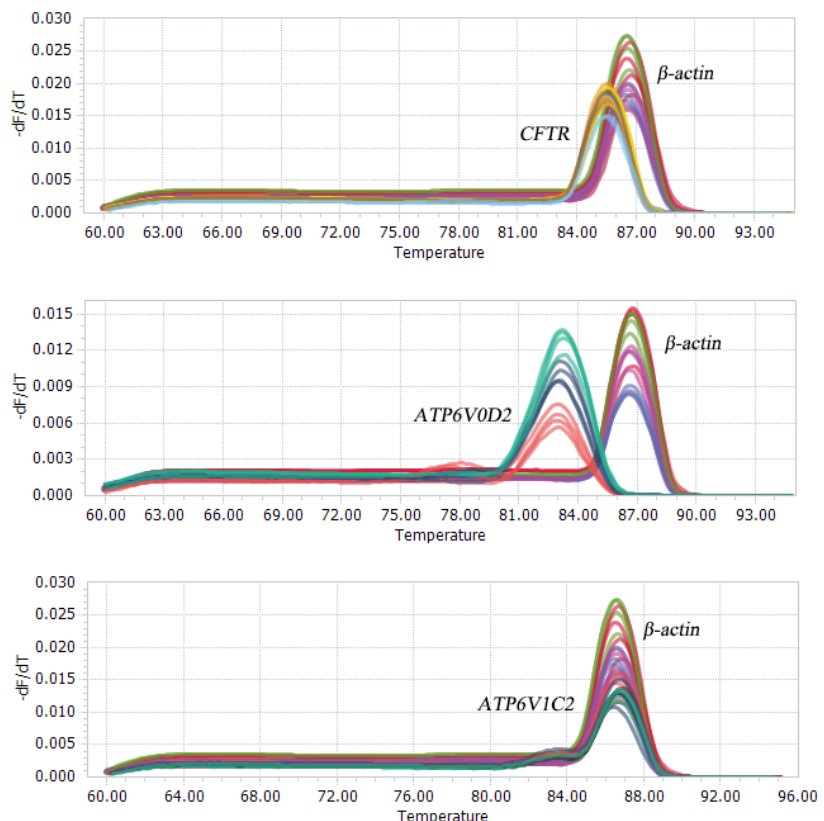
Figure 4. Results of conventional PCR amplification of β -actin, CFTR, ATP6V0D2, and ATP6V1C2 mRNAs. 1. Newborn group; 2. Juvenile group; 3. Adult group; and 4. Elderly group.